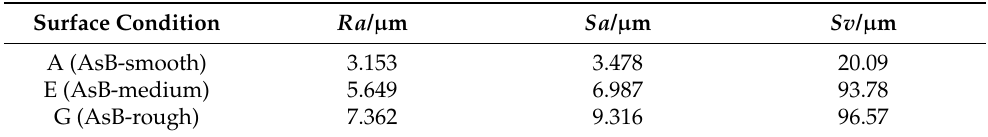
Table 6. Surface texture parameters for comparison with the literature, cut-off 0.8 mm. Evaluated for one specimen per surface